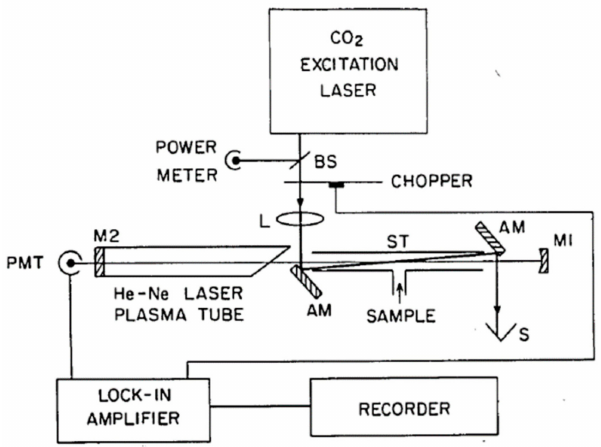
Figure 10. Schematic of an HeNe-based intracavity photothermal gas sensor. BS—beam splitter, AM—aluminum mirror, M1; M2—laser resonator mirrors, PMT—photomultiplier tube, S—beam stop, ST—gas sample cell. Reprinted with permission from [55] C The Optical